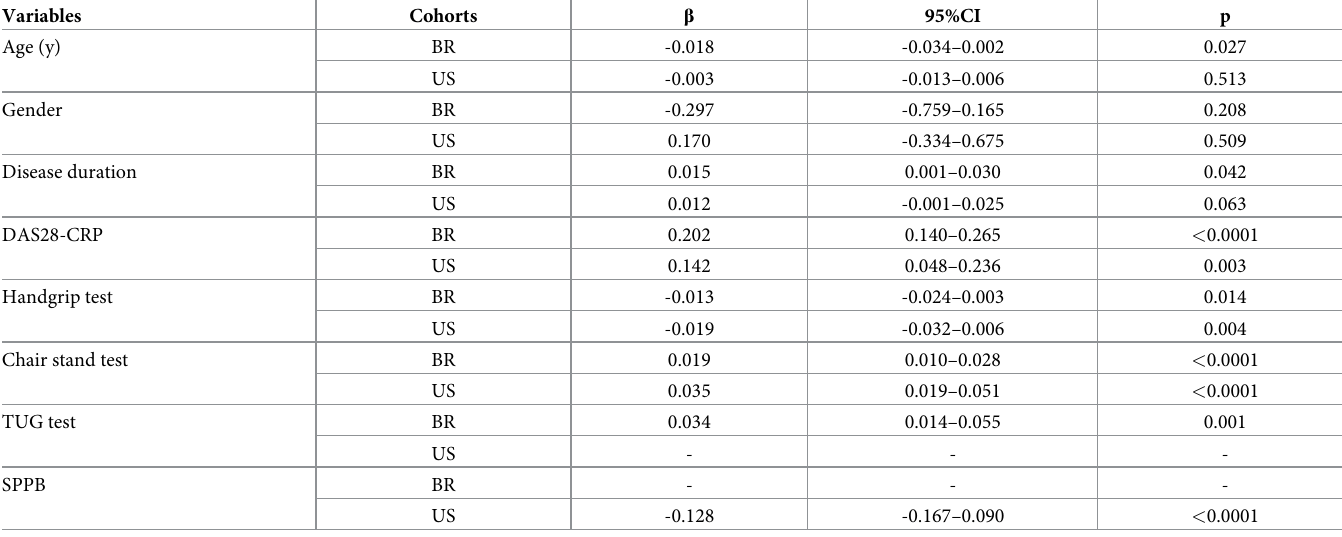
Table 5. Evaluation of continuous variables those were associated with the HAQ-DI in longitudinal analyses. The beta-coefficient represents the relationship between the change in the variable and the change in HAQ-DI over the same follow-up